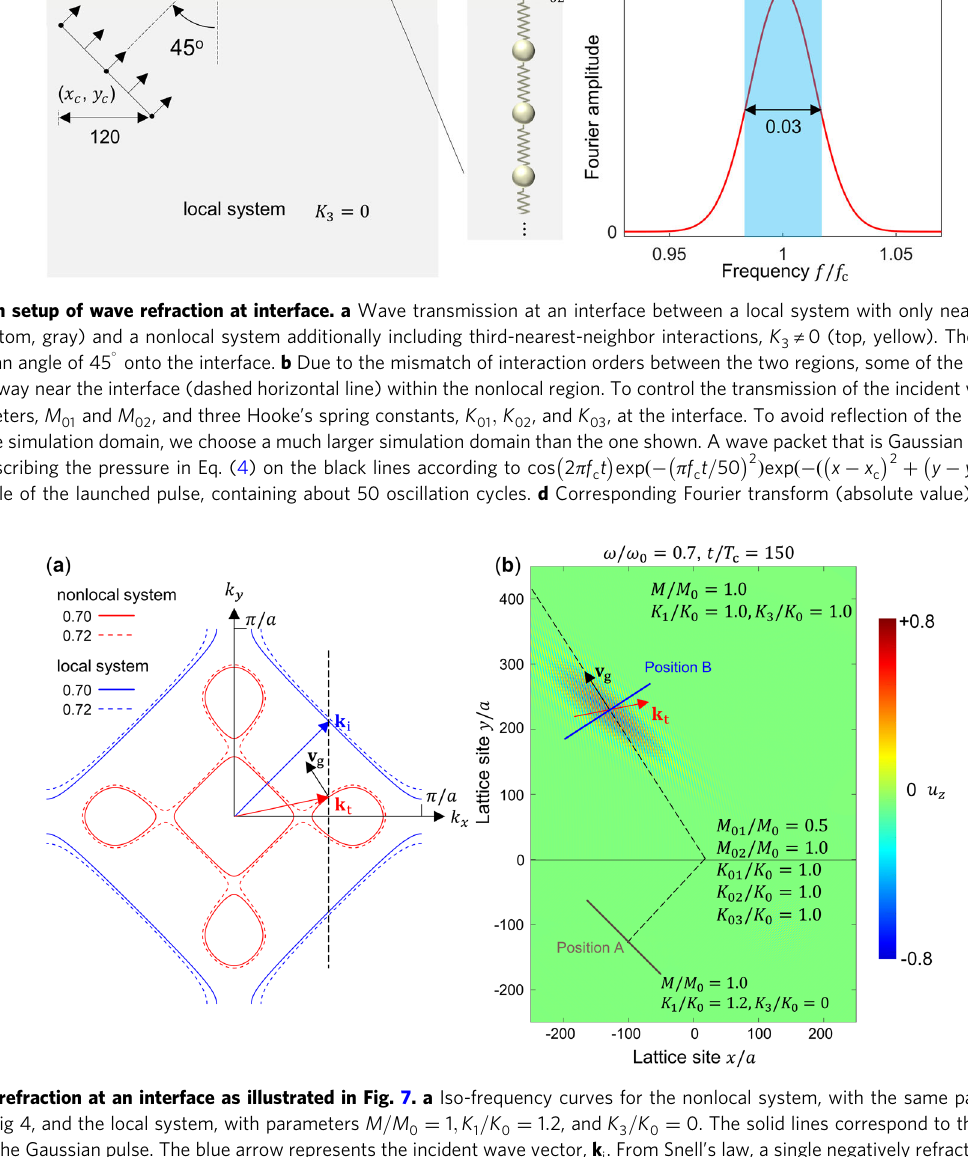
’ s law, a single negatively refracted mode with wave i . From Snell